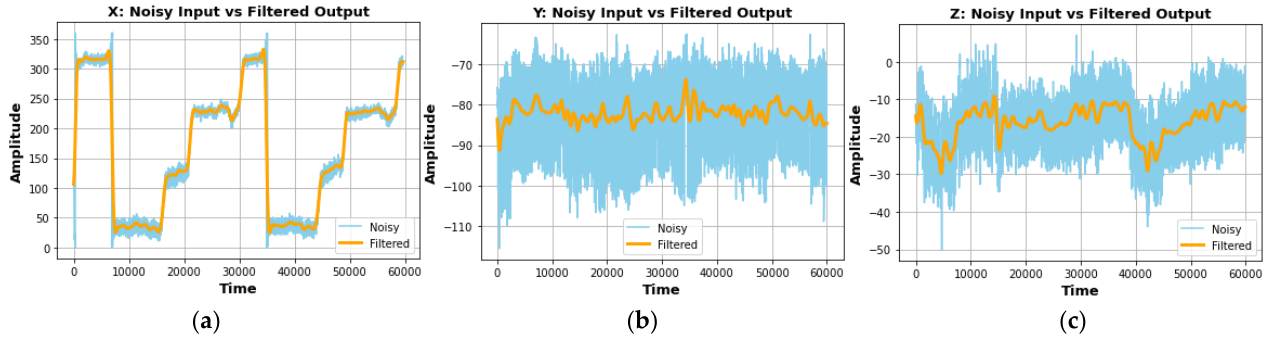
Figure 2. Signal denoising using second-order Chebyshev type-I filter with a cutoff frequency equal to 0.001. ( a ) MobiAct_v2.0 magnetometer x-channel, ( b ) MobiAct_v2.0 magnetometer y-channel, and ( c ) MobiAct_v2.0 magnetometer z-channel.